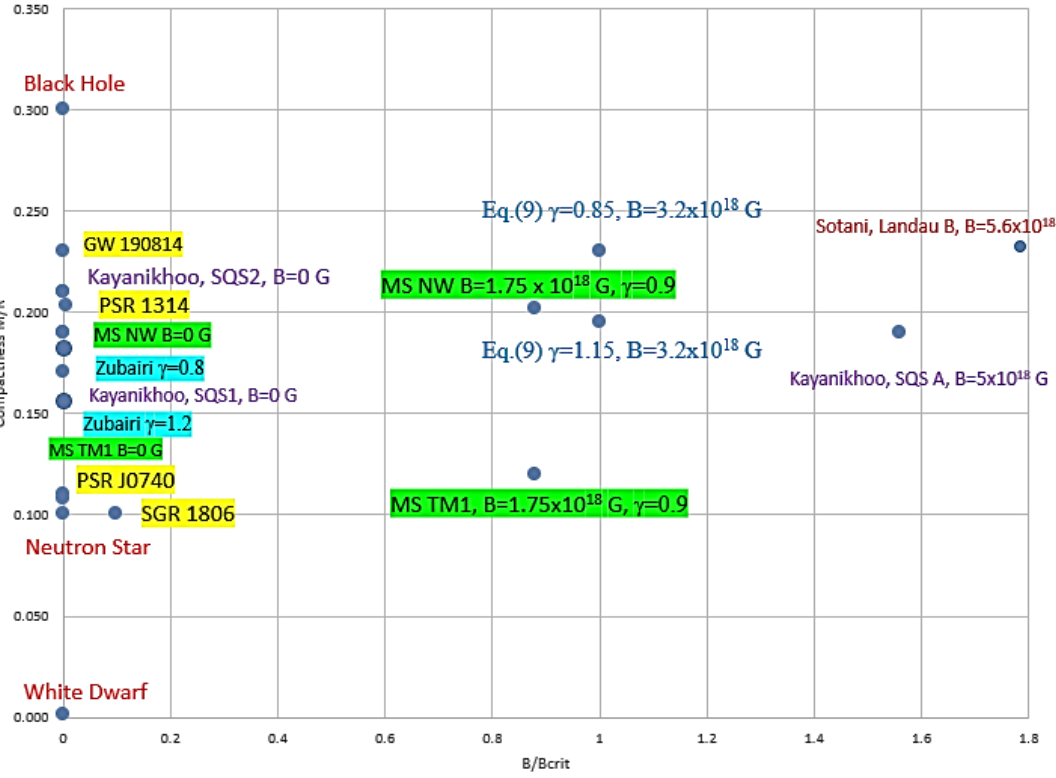
Figure 3. Comparison of models. The models from Kayanikhoo, Mallick, Sotani and Zubairo are compared with the results for Equation (9) and with observational data from pulsars PSR 1314, PSR J0740, Magnetar SGR 1806 and Gravity Wave event GW 190814 for compactness; magnetic field is compared to the critical field for Equation (9) and